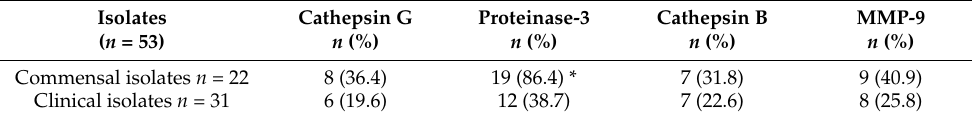
Table 2. Biofilm formation in S. epidermidis isolates in the presence of neutrophils’ proteases . Isolates